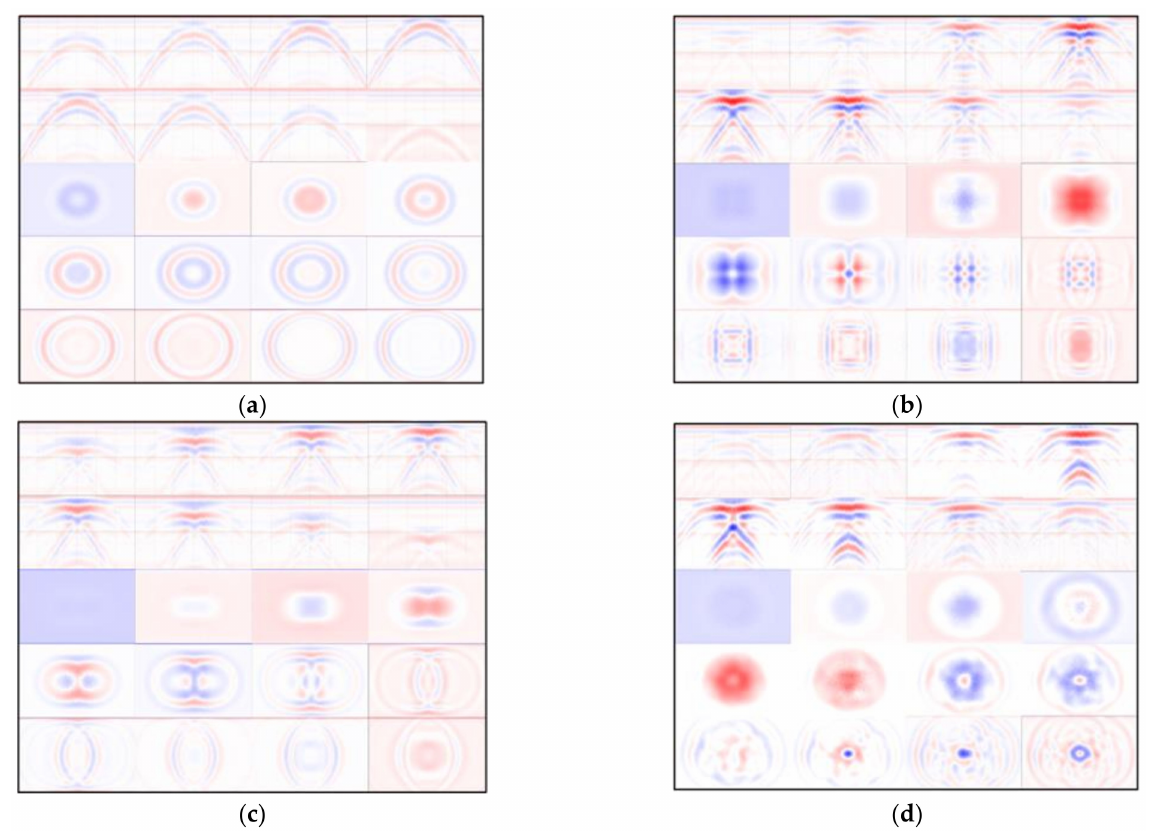
Figure 6. The 2D GPR morphological images of ( a ) a spherical cavity, ( b ) a rectangular cavity, ( c ) a cylindrical cavity, and ( d ) an irregular cavity.